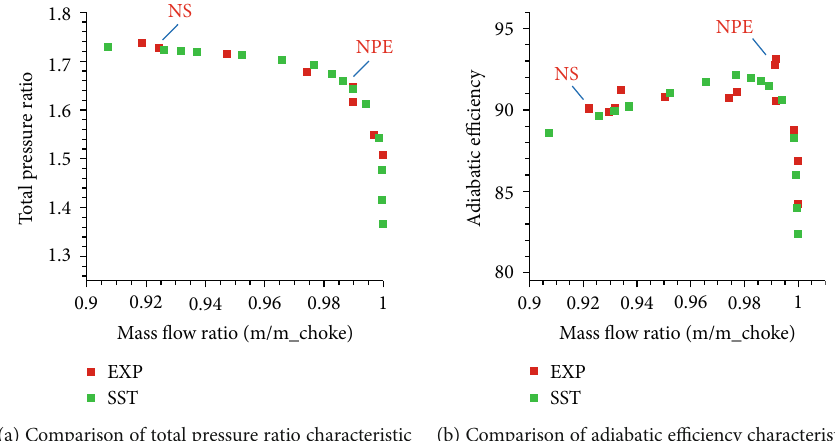
Figure 5: Computed and measured overall performance characteristics for Rotor 67.